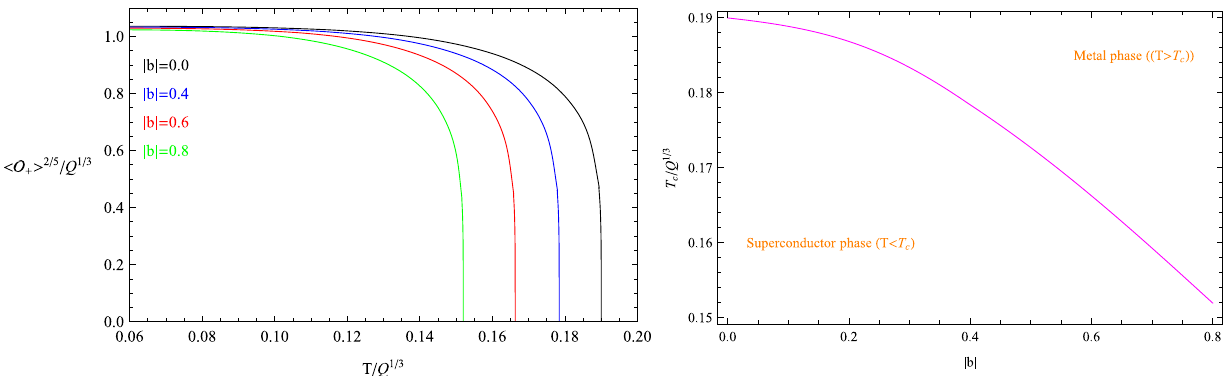
is for | b | = 0 . 8. The right plot presents the phase structure of scalar operator with LNE in AdS black hole background